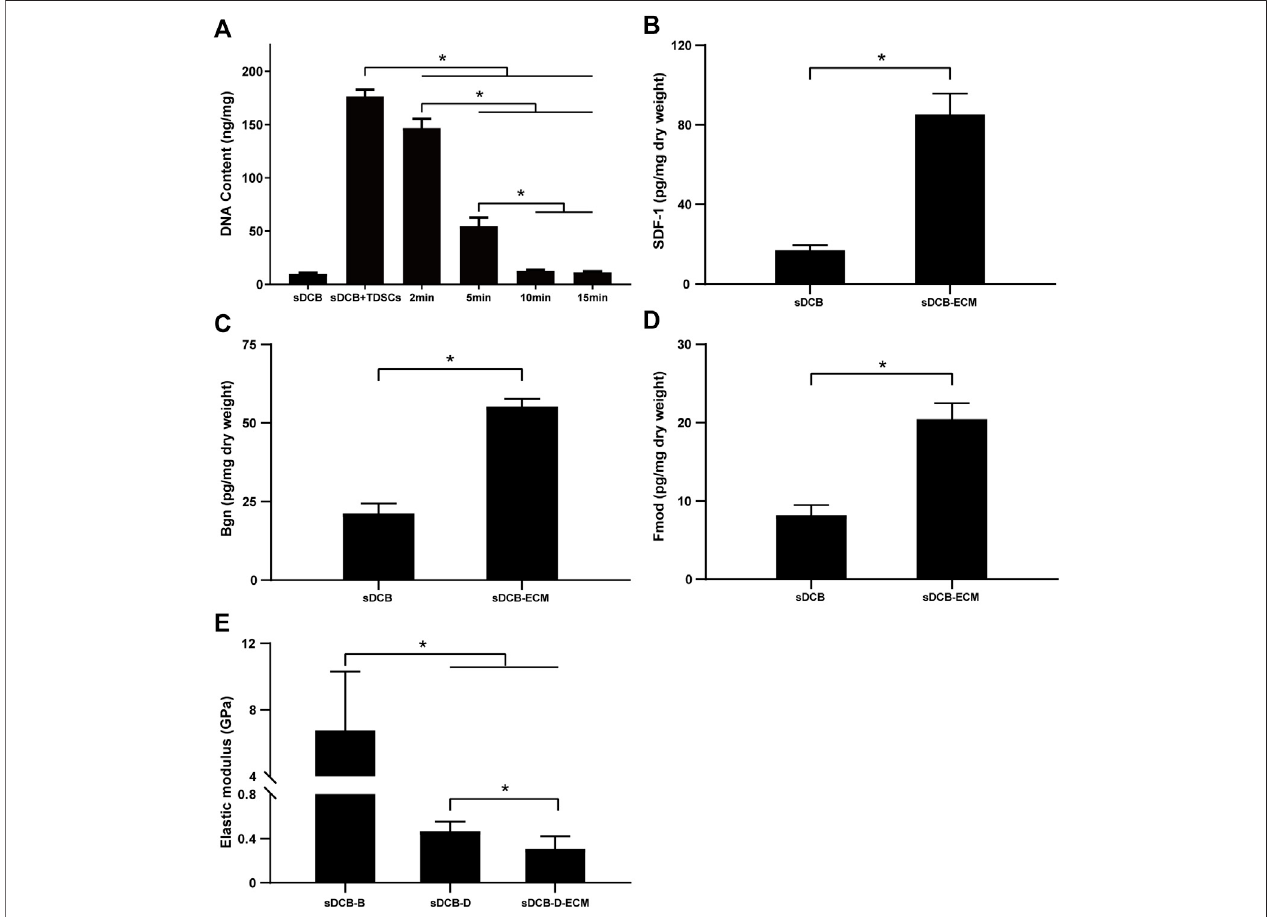
FIGURE 4 | (A) DNA content of sDCB before and after the decellularization treatment with different time. (B) The contents of SDF-1 in the sDCB and sDCB-ECM. (C) ThecontentsofBgninthesDCBandsDCB-ECM. (D) ThecontentsofFmodinthesDCBandsDCB-ECM. (E) ThesurfaceelasticmodulusofsDCB-B,sDCB-Dand sDCB-D-ECM. * Indicated p <